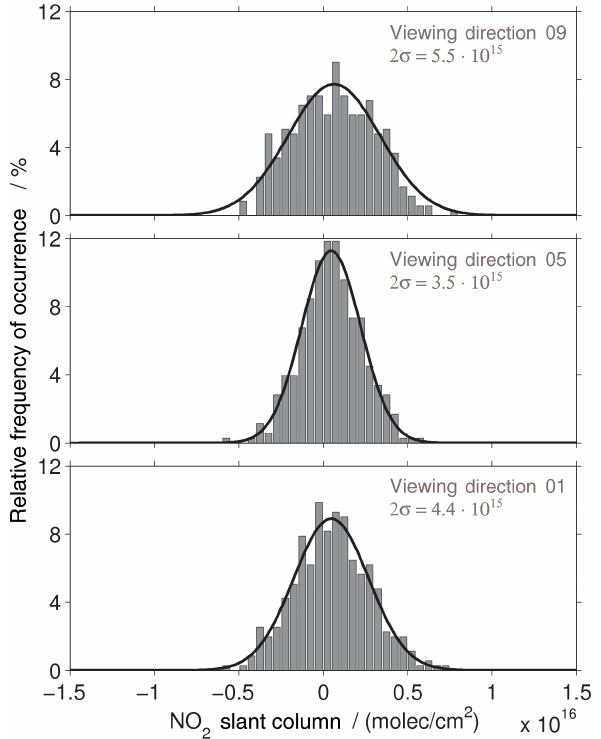
Figure 8. Histograms for the distribution and variability of NO 2 amounts in three of the nine different viewing directions used for uncertainty analysis. Data used for this figure are recorded 3min around the 1min reference ( I 0 in the DOAS fit).